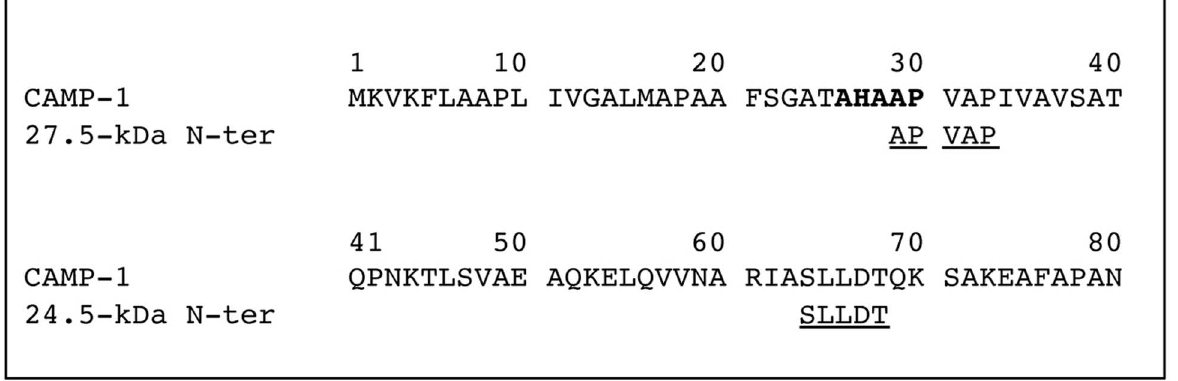
Fig 6. N-terminal sequencing of the protein of interest. Surface protein extracts were electrophoreticallyseparated in 10% SDS-PAGE gels (13 x 13 cm), with detectionby Coomassie blue staining.Proteins of interest were excised from the gel, eluted and subjectedto N-terminal sequencing by Edman degradationto obtain the first five amino-acid residues of each protein, as describedin Materials and Methods. N-terminal sequenceswere comparedto the P . acnes CAMP factor 1 sequence(referencestain NCTC 737, GenBank accession number AY527218.1). The peptidesignal cleavagesite of CAMP factor 1 is shown in bold.